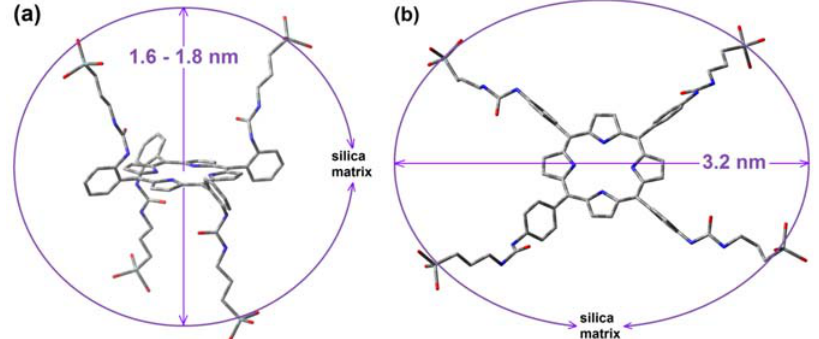
Figure 15. Depending on the position of amino groups in: ( a ) H H To(p-NH )PP ( b ) species, small or large pore widths, (  ), can be obtained. For 2 2 simplicity, hydrogens in these structures have been